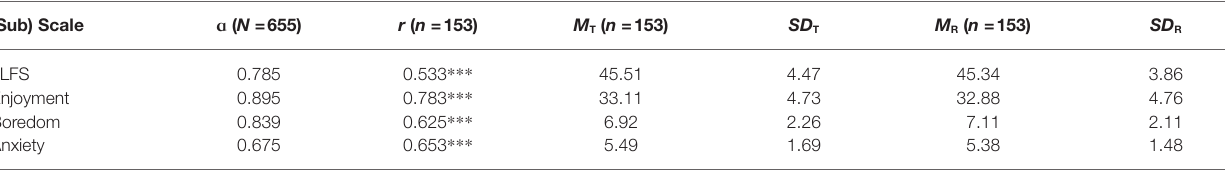
TABLE 5 | Internal consistency and 2-week test-retest reliability of scale and subscales.